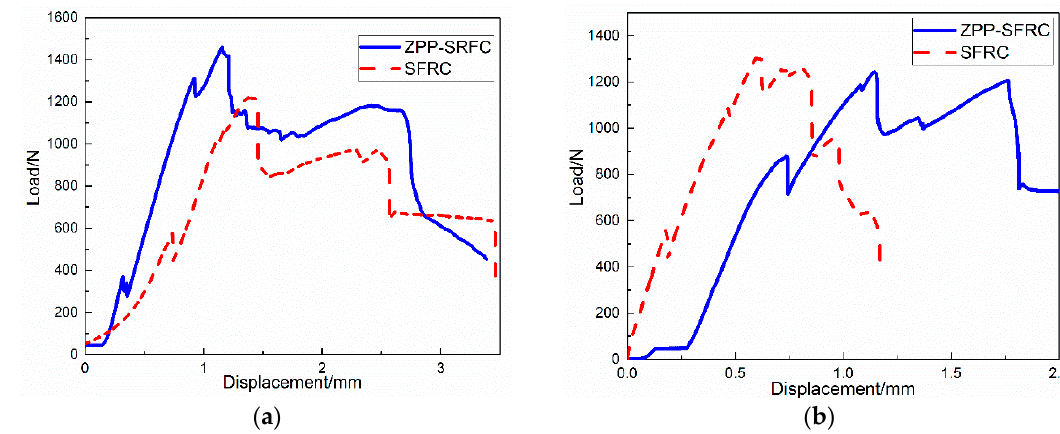
Figure 3. The relationship between load and displacement of the samples under different environments in the pull-out test: ( a ) NaCl solution and ( b ) without corrosion.